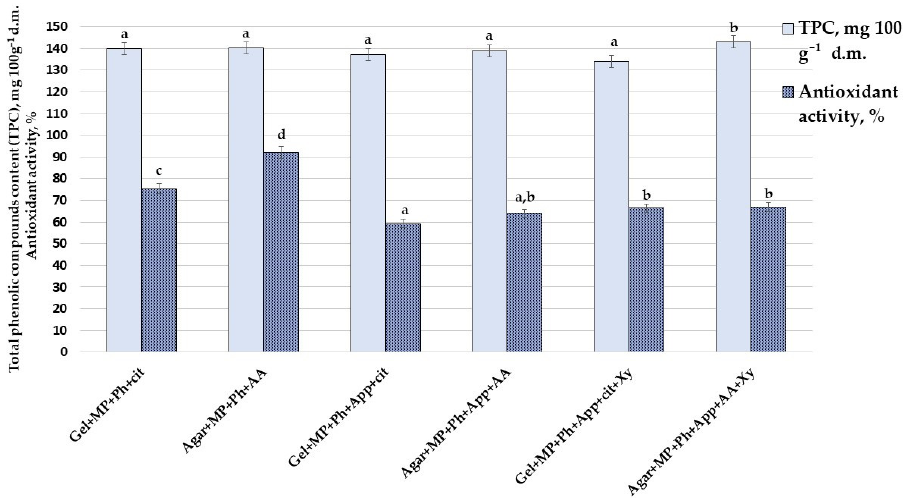
Figure 3. Total phenolic compound (TPC) content (mg 100 g − 1 d.m.) and antioxidant activity (%) of